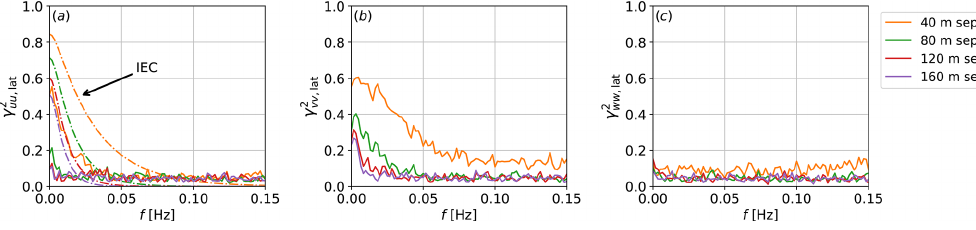
Figure 10. Coherence of the three turbulence components (a) u , (b) v , and (c) w separated laterally. Dash-dotted curves shown are obtained from the IEC-recommended Kaimal spectrum with the exponential-coherence model, where